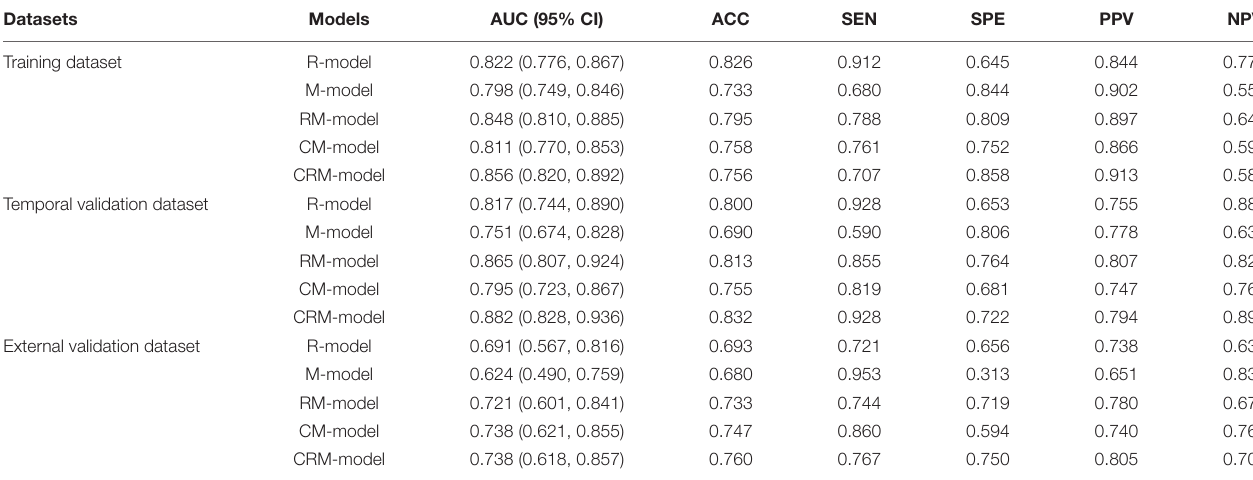
TABLE 4 | Performance of the radiomics, morphological, radiomics-morphological, clinical-morphological, and clinical-radiomics-morphological models.